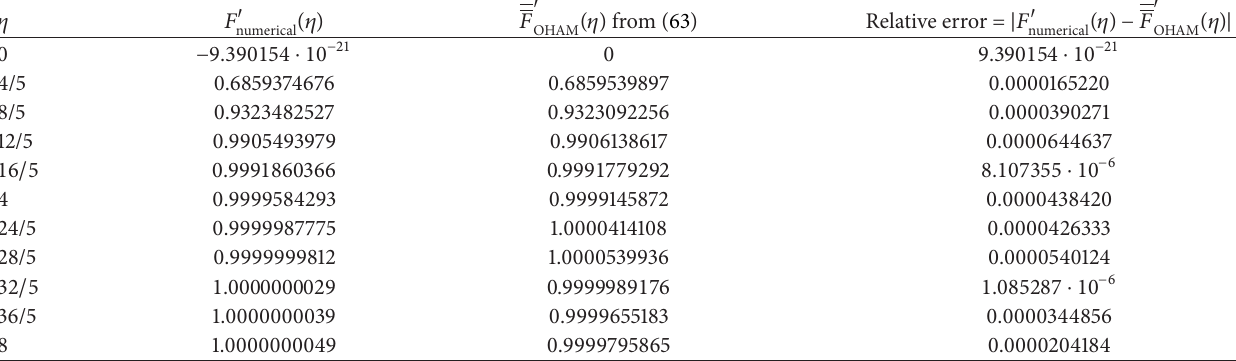
󸀠 (𝜂) obtained from (63) and numerical results for 𝛽 = 1 .